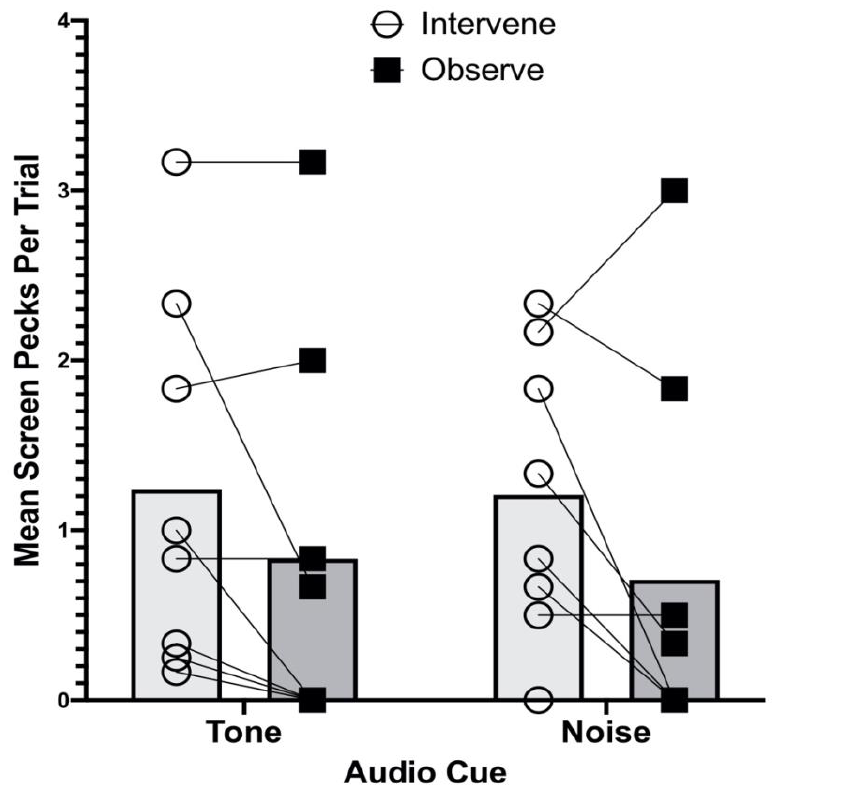
Figure 3. Mean screen pecks per trial per bird (n=8 grackles) in the Intervene (open circles) and Observe (black squares) conditions depending on whether the audio cue was the tone or noise. Within individual performances are shown by the lines connecting the circles to the squares. The bars indicate the group average per condition (light gray=Intervene, dark